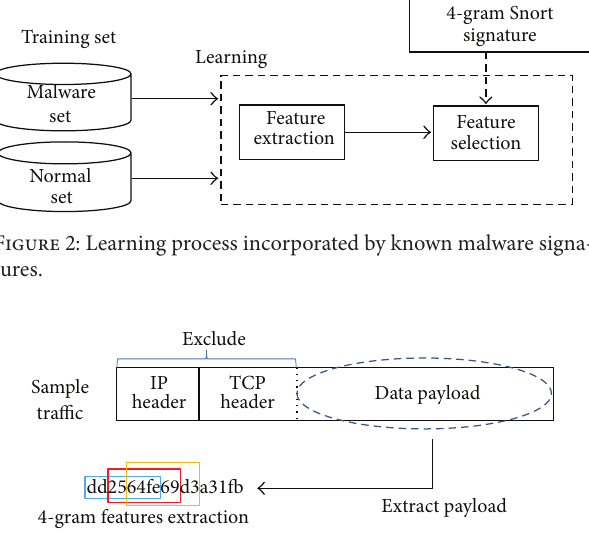
Figure 3: Extract 4-gram features from traffic payload in training set.